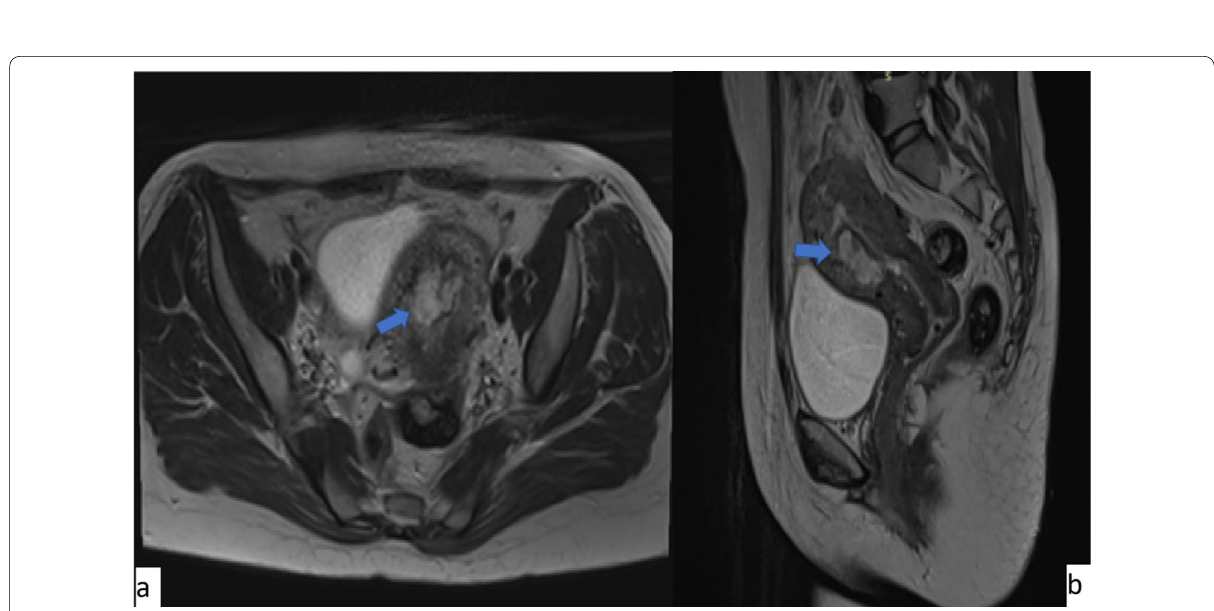
Fig. 2 In the myometrium, hyperintense lesions can be detected in axial ( a ) and sagittal ( b ) T2WIs (blue